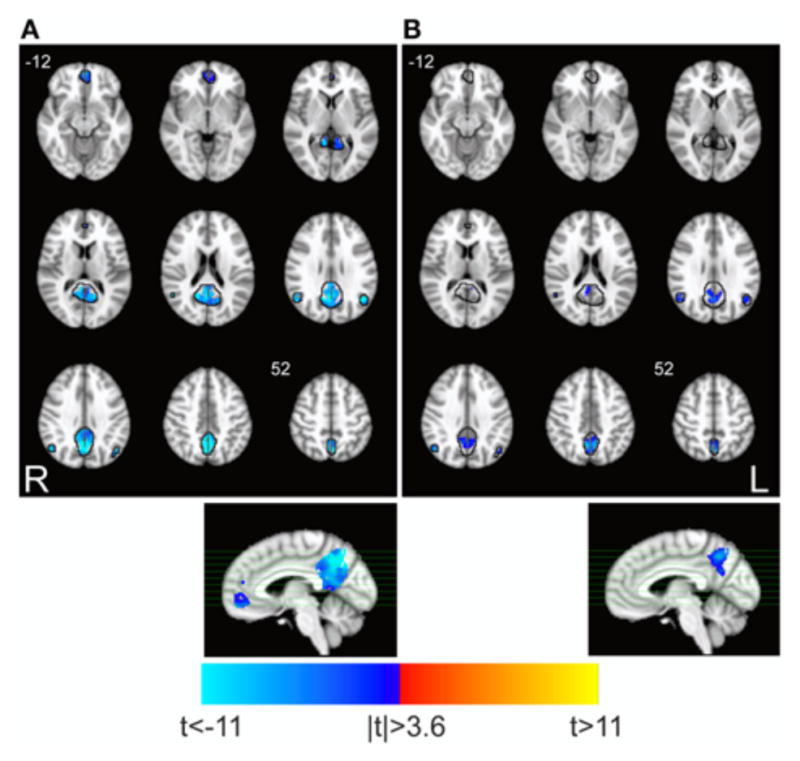
Task-related changes in spectral and spatio-temporal parameters within DMN. Maps show the significant task-associated changes of (A) fALFF and (B) FC for the test TASK > REST (paired t-test, p < 0.05 corrected. 3dClustSim parameters: single-voxel p < 0.001; cluster size threshold, 10 and 18 voxels, for fALFF and FC, respectively). Black lines identify the boundaries of DMN as identified by ICA, where analysis was restricted. Task-related decrements of fALFF and FC are apparent in the posterior DMN, and in the anterior cingulate only for fALFF.